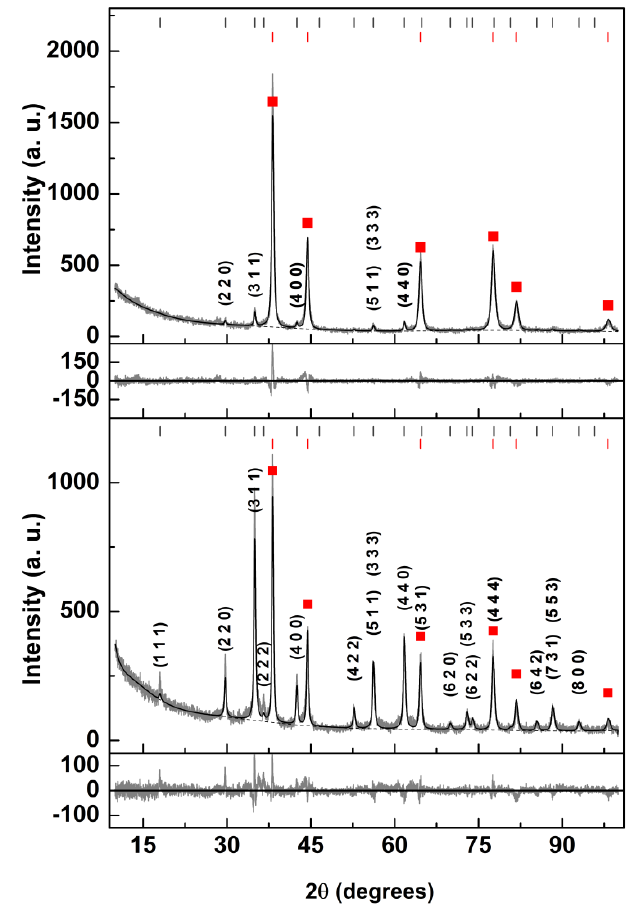
Figure 7. X-ray diffraction pattern of manganese ferrite/gold core/shell nanoparticles (above) and manganese ferrite decorated with gold nanoparticles (below). Gray lines: Experimental patterns; black lines: Fitted patterns; short-dashed lines: background. Miller indices of manganese ferrite are indicated in black; the gold peaks are marked as red squares. Table 3. Calculated R P and χ 2 parameters, phase sizes, and percentages obtained by Rietveld re- finement of X-ray diffraction patterns of Au@MnFe 2 O 4 (gold-decorated nanoparticles) and MnFe 2 O 4 /Au (core/shell nanoparticles).